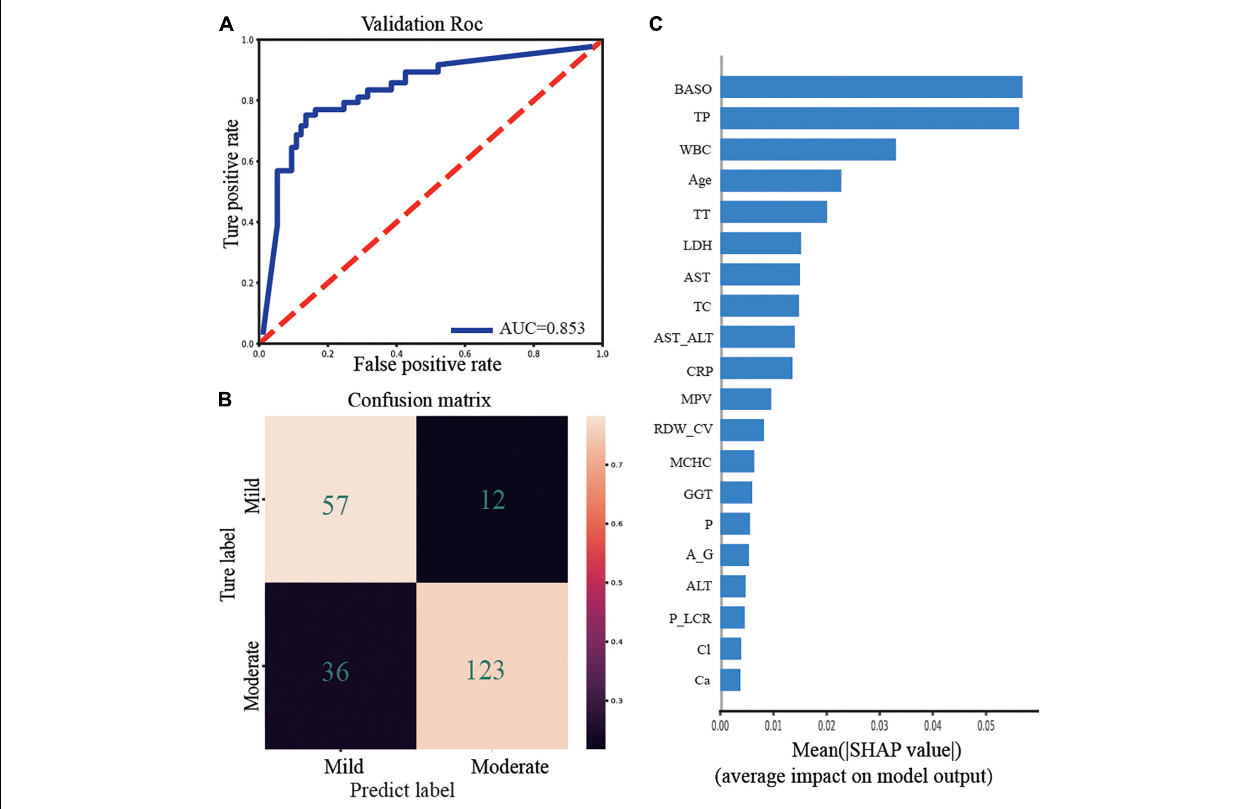
FIGURE 2 | Prediction classifier model evaluation and feature importance. (A) ROC curve for predicting mild and moderate COVID-19. (B) Confusion matrix of Random forest classifier of mild and moderate with hematology indices. (C) Barplot of feature importance for the prediction model. BASO, basophil cell count, TP, total protein, WBC, white blood cell, Age, the age of patients, TT, thrombin time, LDH, lactic dehydrogenase, AST, glutamic oxalacetic transaminase, TC, total cholesterol, AST_ALT, AST/ALT, CRP, C-reactive protein, MPV, mean platelet volume, RDW_CV, red blood cell distribution width, MCHC, mean corpuscular hemoglobin concentration, GGT, glutamyl transpeptidase, P, phosphorus in the blood, A_G, albumin/globulin, ALT, alanine transaminase, P_LCR, platelet-large cell ratio, Cl, the chlorine in the blood, Ca, calcium.